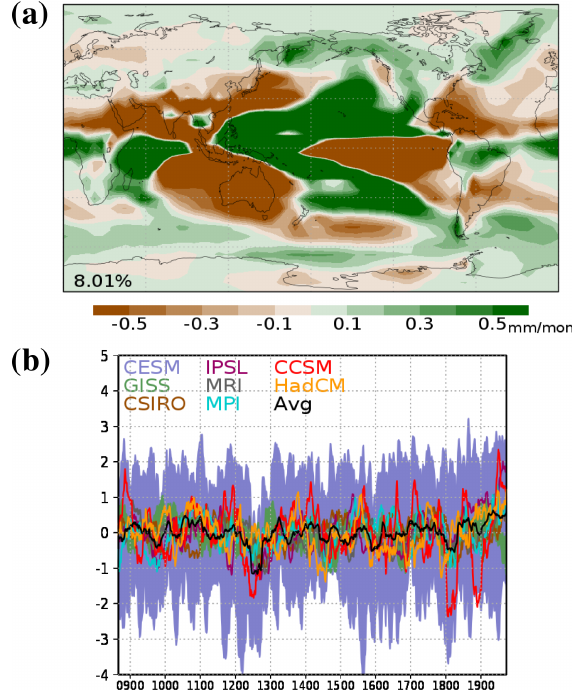
Figure 10. (a) First EOF of precipitation for the ensemble of simu- lations included in Table 1. The percentage of explained variance is shown within the EOF map. (b) PC time series for each simulation. The average of all the simulations is also included (black line).